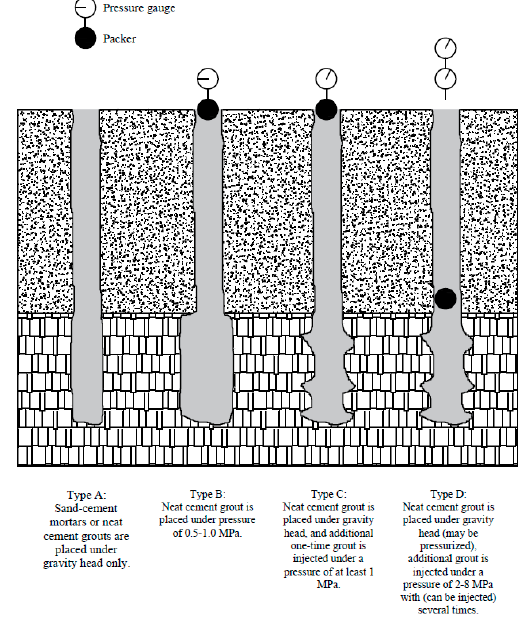
Figure 4. Micropile classification system based on type of grouting (after [1]).